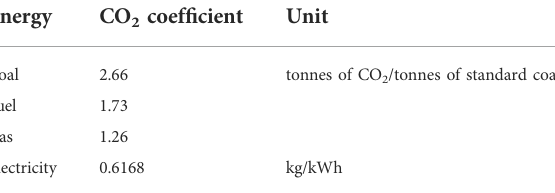
TABLE 2 CO 2 emission coef fi cients for different energy types.